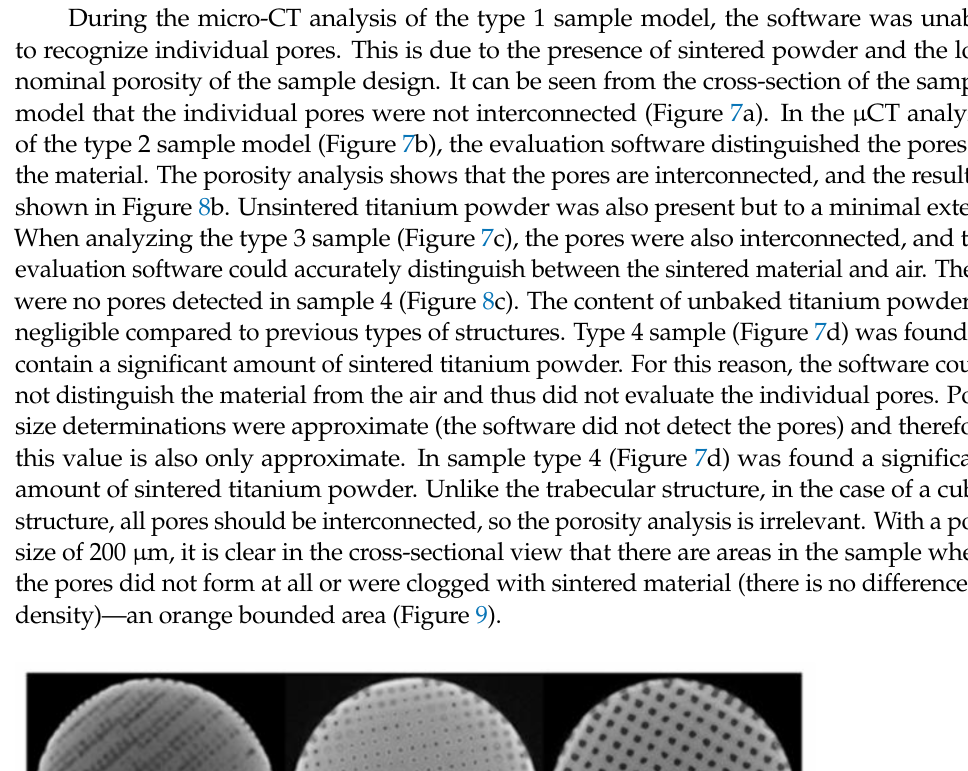
Figure 8. Sample 1 with a porosity of 200 µ m with marked pores ( a ), 400 µ m ( b ), 600 µ m ( c ).